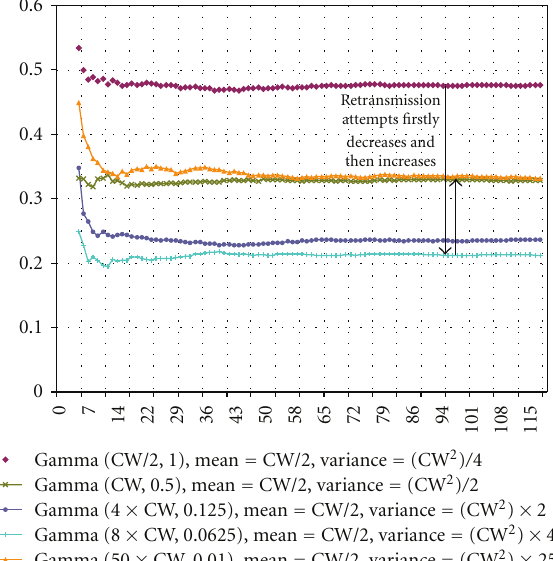
Figure 10: Mean number of retransmission attempts for five di ff erent scenarios with the same Gamma PDF mean but di ff erent variances ( n = 24). This quantity is a direct sign of collision probability in network. In this figure, with variance increment, firstly the mean retransmission attempt decreases (gets better) and then increases (gets